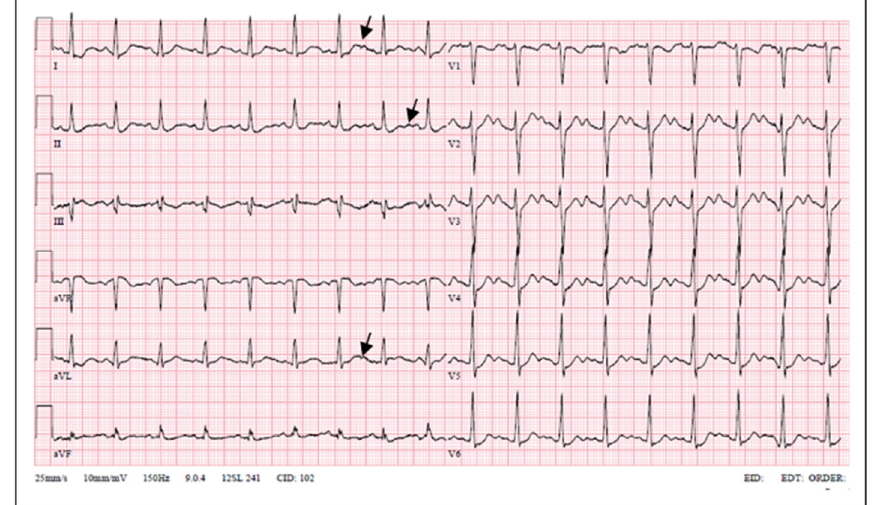
Figure 2. Patient’s ECG on admission (notched T waves, QTc 532 ms).